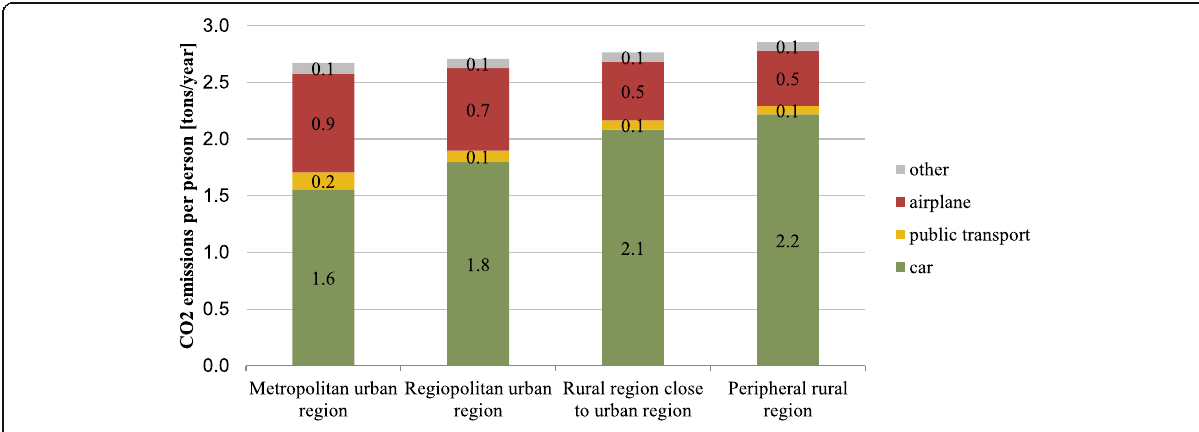
Fig. 1 Annual CO2 emissions per capita, differentiated by mode of transport and spatial type